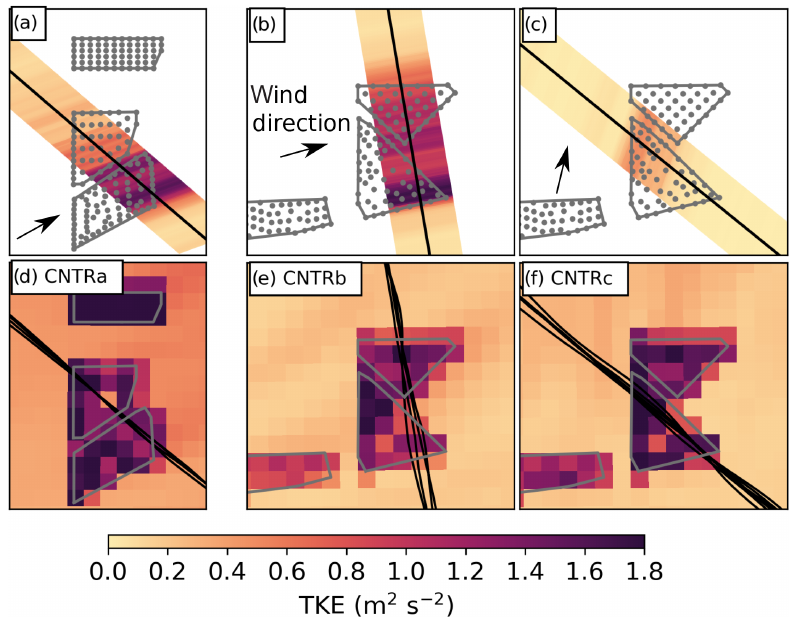
Figure 9. As in Fig. 7 but for the